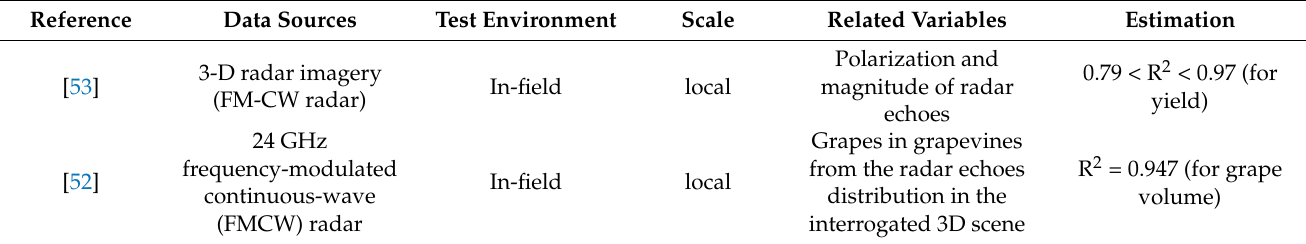
Table 8. Summary of records included in the systematic review (G—data-driven models based on radar data processing). Reference